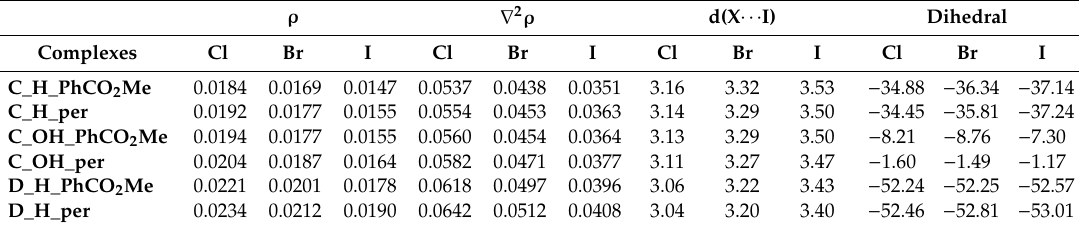
Table 5. Electron density at the BCP ( ρ ), Laplacian ( ∇ 2 ρ ), and interaction distance (Å) for all the complexes studied at m062x / aug–cc–pVDZ computational level. Dihedral angles (Figure 6). ρ ∇ 2 ρ d(X ··· I) Dihedral Complexes Cl